Question: Sum up the contents of this chart in one sentence.
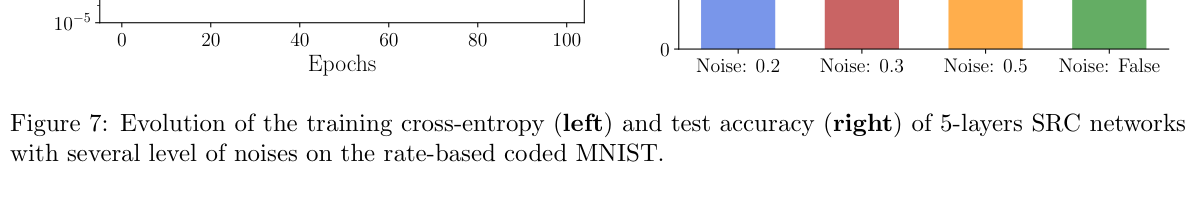
Answer: Evolution of the training cross-entropy (left) and test accuracy (right) of 5-layers SRC networks with several level of noises on the rate-based coded MNIST.